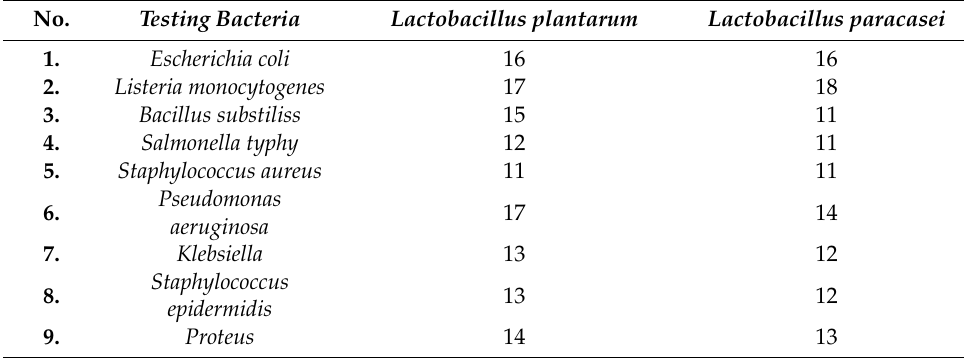
Table 2. Antimicrobial activity analysis of LAB in the form of clear zone diameter (mm).